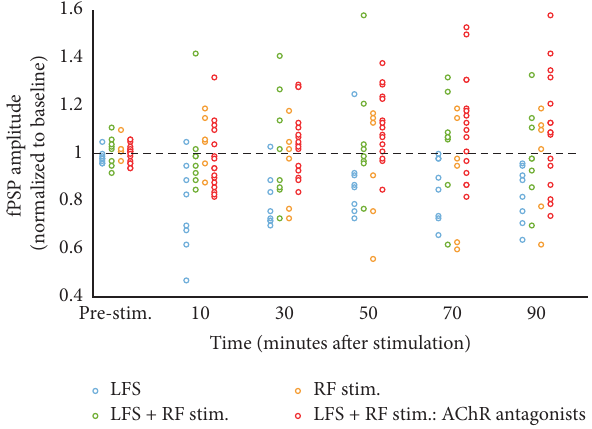
Figure 2: Plot of fPSP amplitude (normalized to baseline) in V1 of individual rats at six time points throughout the experiment. Application of LFS ( 𝑛 = 8 ) to the LGN resulted in significant depression of fPSP amplitude in the large majority of animals (7/8 or 8/8, depending on the time following stimulation). Combined LFS + RF stimulation ( 𝑛 = 8 ), RF stimulation alone ( 𝑛 = 6 ), or LFS + RF stimulation in rats pretreated (i.p.) with acetylcholine receptor (AChR) antagonists ( 𝑛 = 16 ) resulted in heterogeneous responses, with about half of the rats in each group exhibiting potentiation, while the remaining ones showed depression of fPSP amplitude at most time points following delivery of the stimulation protocol (the AChR antagonist condition is comprised of 1mg/kg scopolamine, 𝑛 = 6 ; 0.5mg/kg mecamylamine, 𝑛 = 6 ; 10mg/kg scopolamine + 5 mg/kg mecamylamine, 𝑛 = 4 ; total 𝑛 = 16 ; see text and Figure 3 for